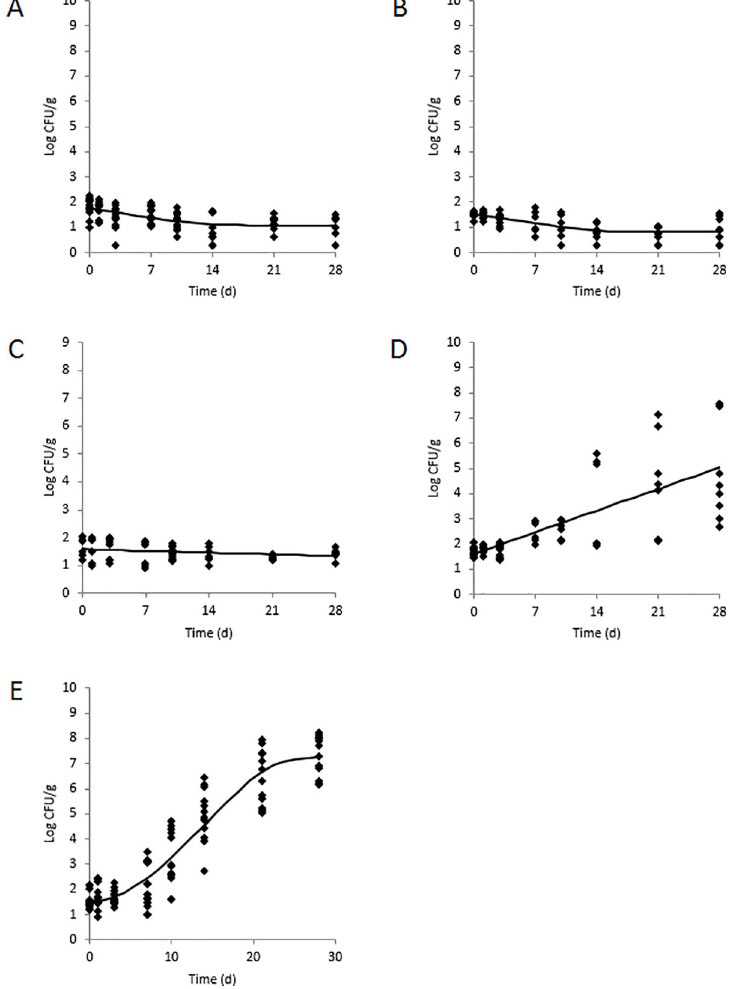
Fig 1. Population dynamics of L . monocytogenes in A) baba ghanoush, B) tahini, C) pesto, D) hummus, and E) guacamole during 28 d storage at 10˚C. Observed data (black circles) with standard deviations (n = 9) and predicted growth models (solid black lines) are